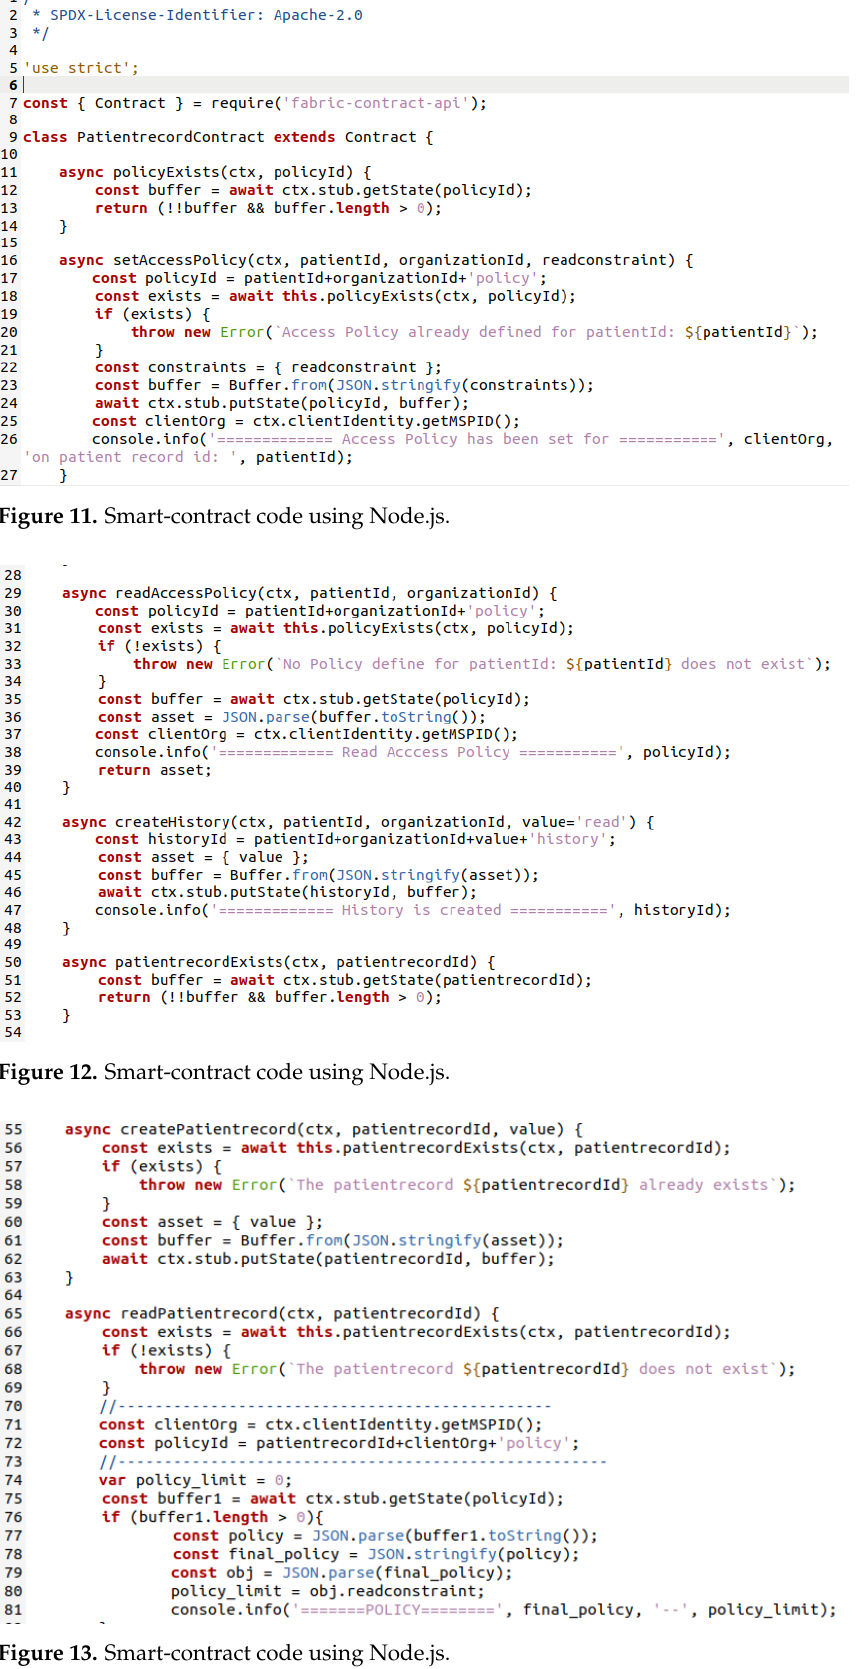
Figure 13. Smart-contract code using